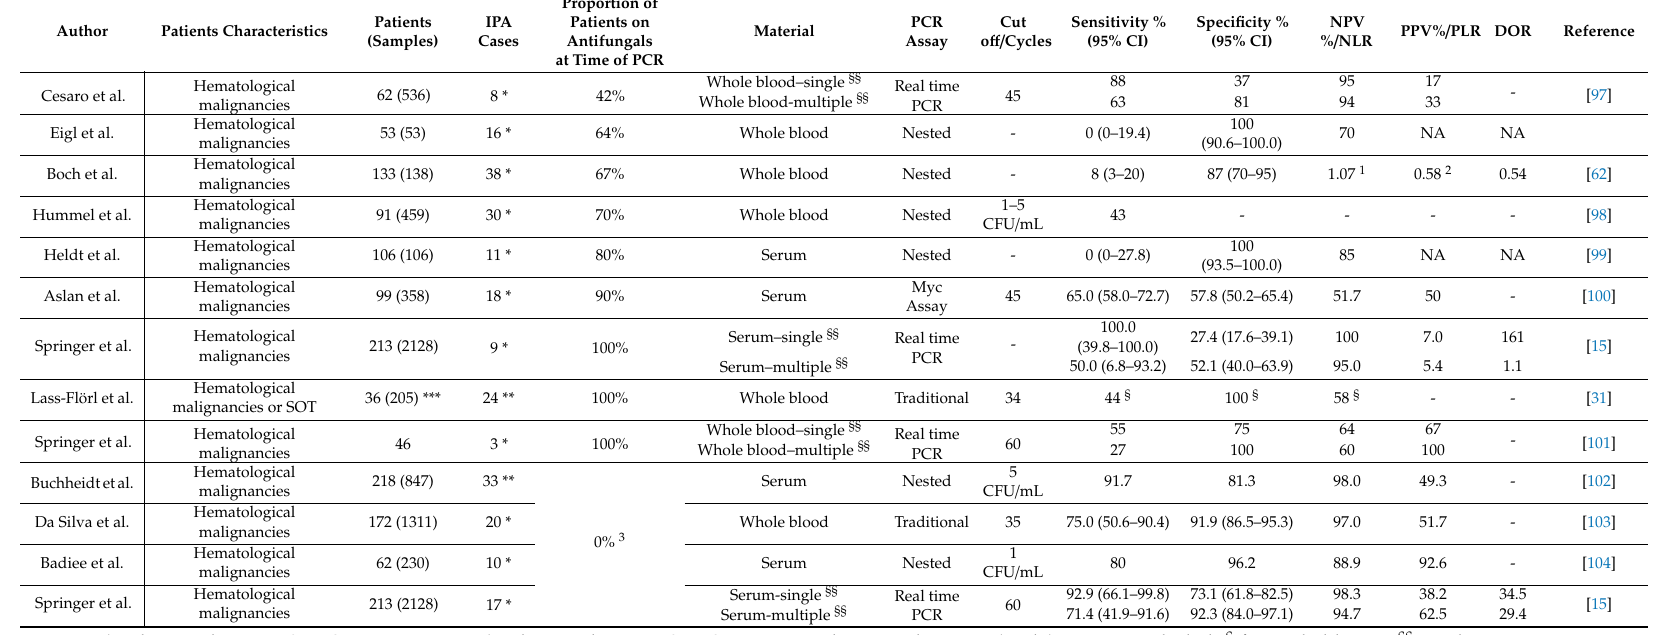
Table 1. Performance of Aspergillus PCR in blood comparing settings with no antifungal prophylaxis versus settings with antifungal